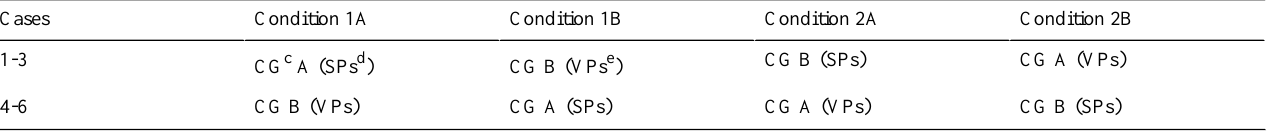
Table 2. Succession through cases and medical content in the experimental conditions a,b .